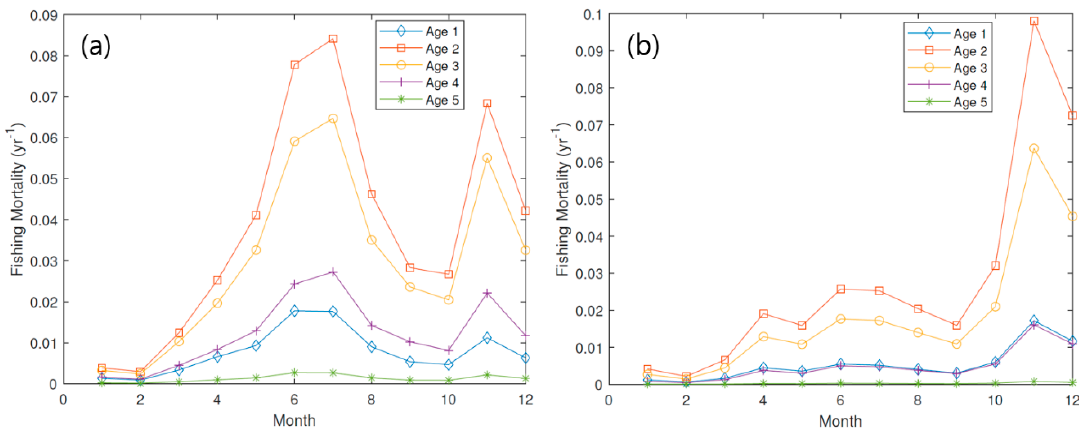
Figure 7. Monthly averaged fishing mortality of sandfish in the eastern coastal waters of Korea when ∑𝐵 (cid:3036) (0) = 8925 and M 0 = 2.83. ( a ) Between 1994 and 1998; ( b ) Between 2005 and 2009.